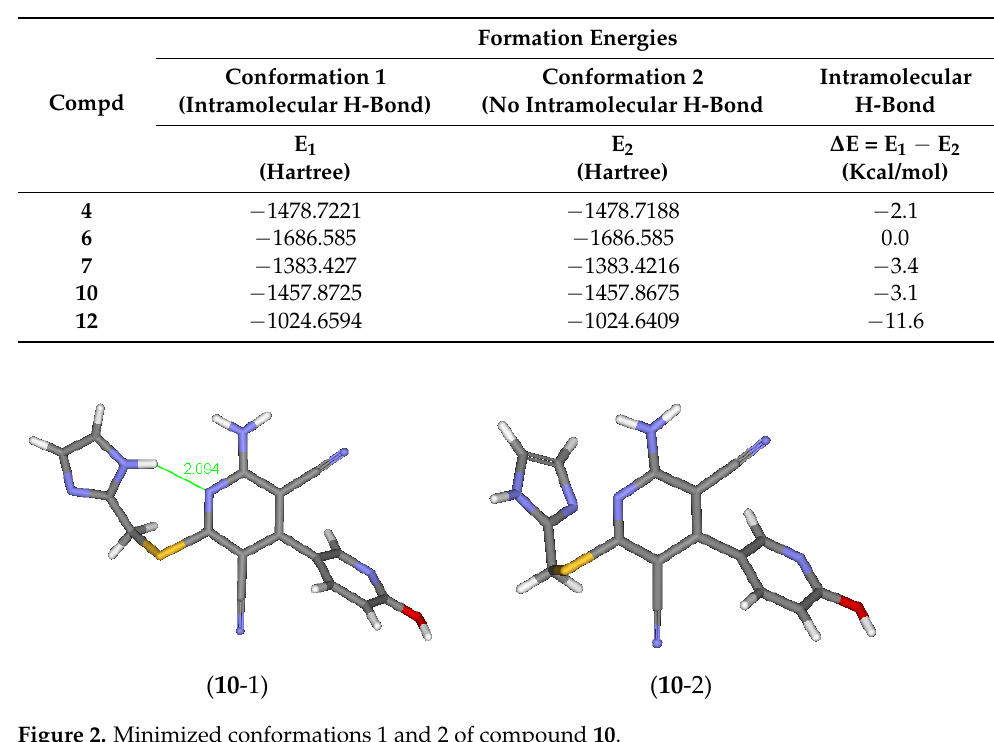
Table 3. Formation energies of selected dicyanopyridine derivatives and evaluation of the relative intramolecular H-bond energy.